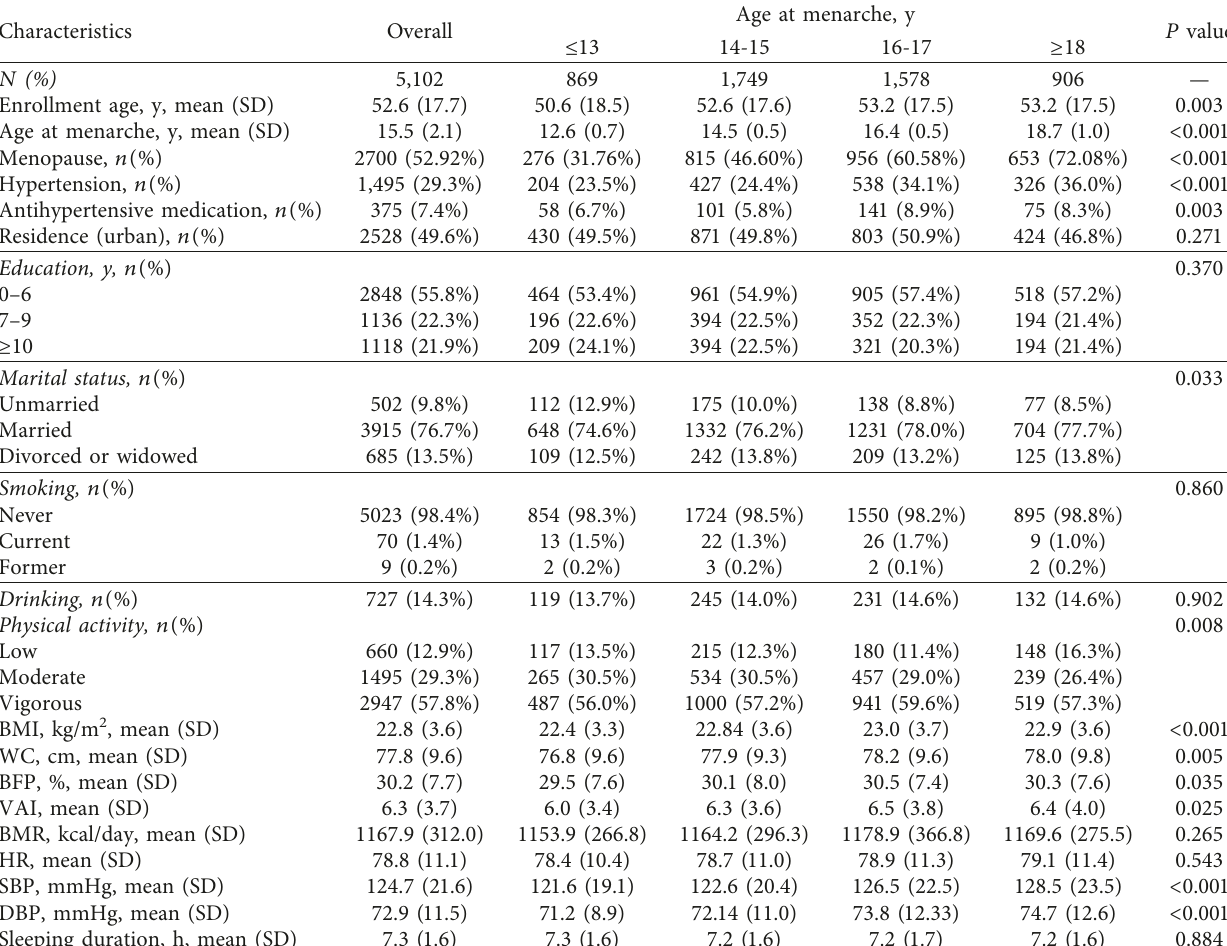
Table 1: Baseline characteristics according to age at menarche.